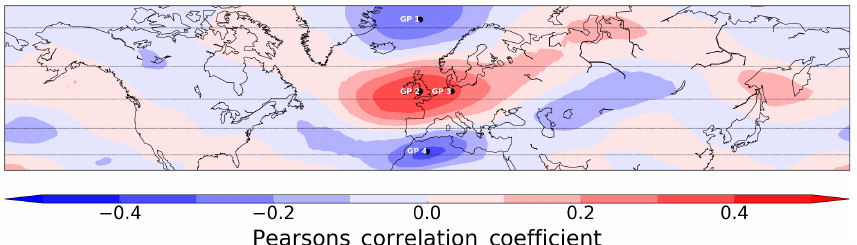
Figure 1. Pearson’s correlation coefficient between blocking index magnitude (K) and UK [PM 10 ] (µg − 3 ) in the UK Midlands region. All data were taken for the winter months (DJF) between January 1999 and December 2008. PM 10 data following a positive or negative BI value were lagged by 1 or 0 days respectively. Grid points selected for further analysis are labelled GP 1 to 4.